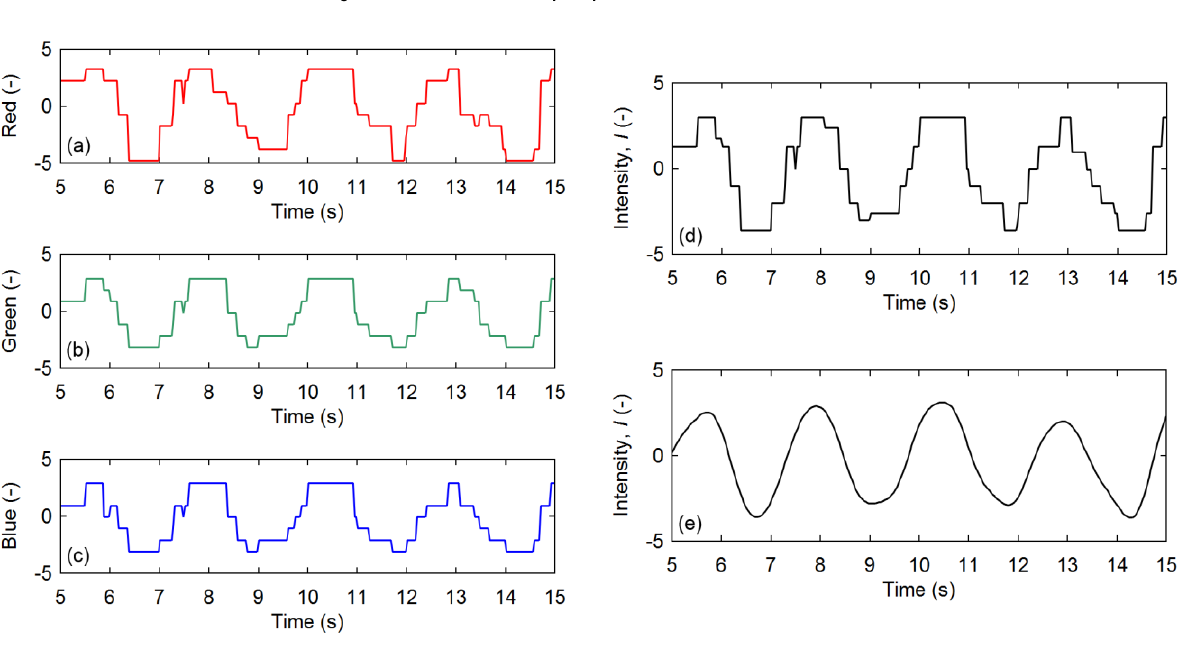
Figure 2. Example of experimental data extracted from a VVS: brightness of ( a ) red; ( b ) green; and ( c ) blue; ( d ) computed intensity (used for subsequent analyses); I, and ( e ) smoothed intensity (for illustrative